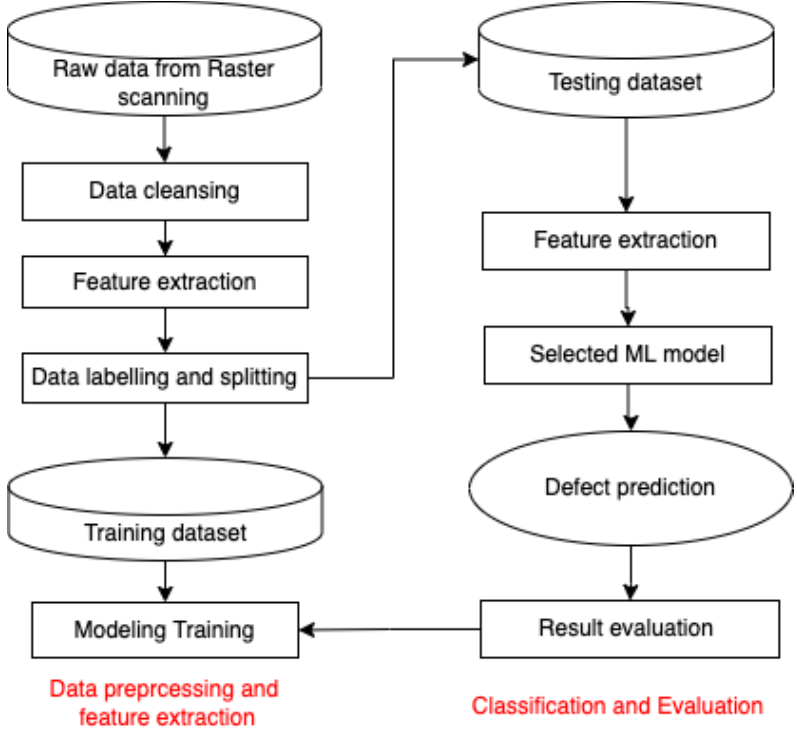
Figure 4. Machine learning classification modelling